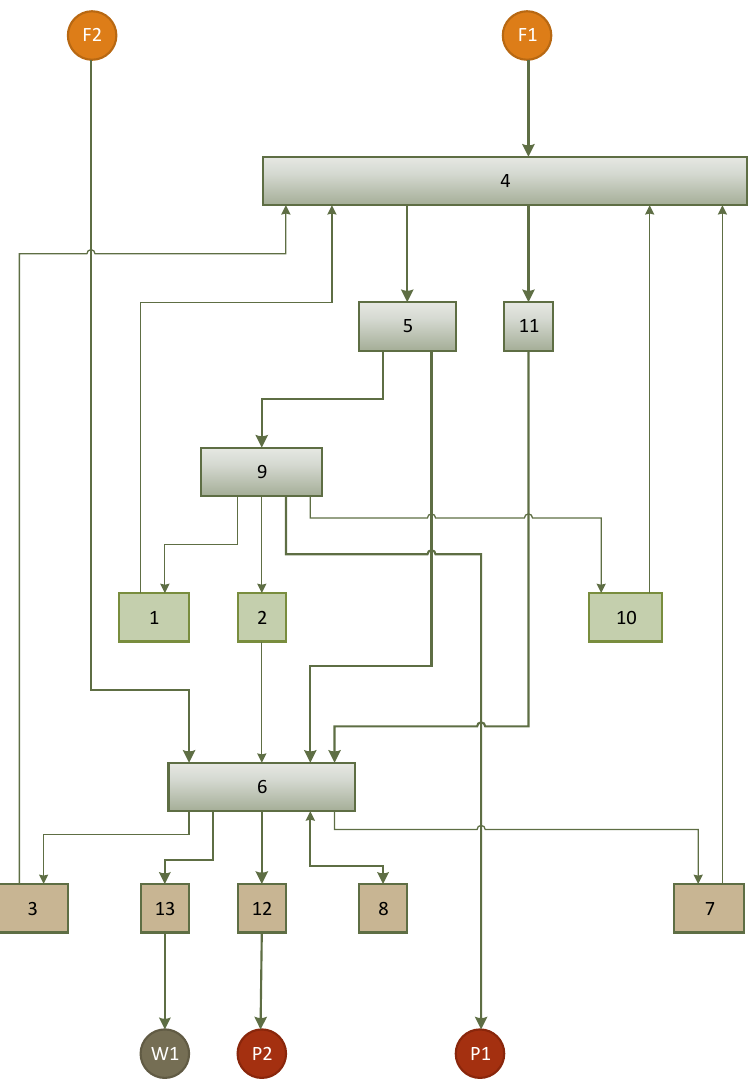
Figure 3. Productive structure of the SOFC-VARS hybrid